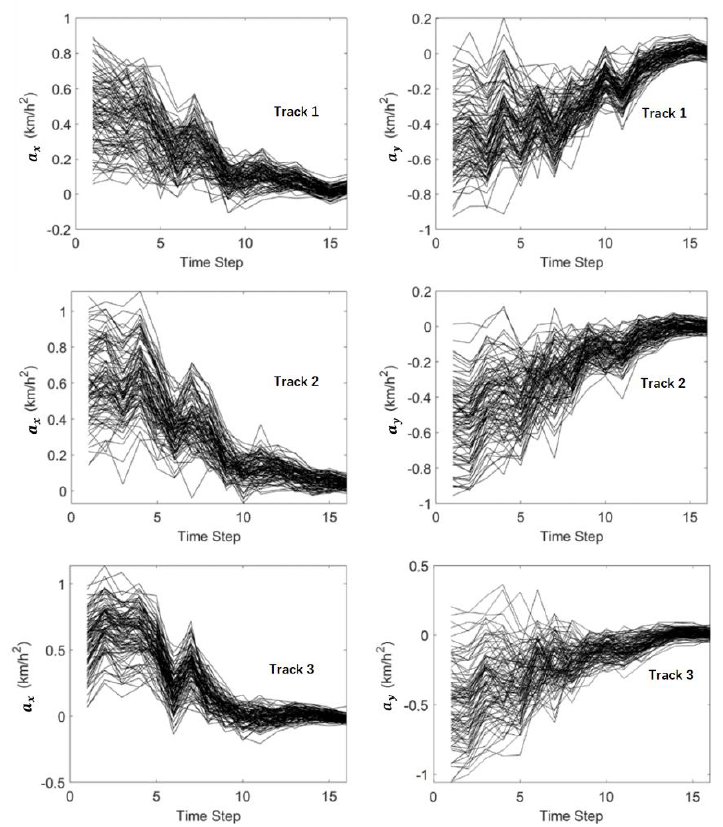
Table 2. History matching results of the accelerations and velocities in the X-direction and Y-direction (units: km/h).